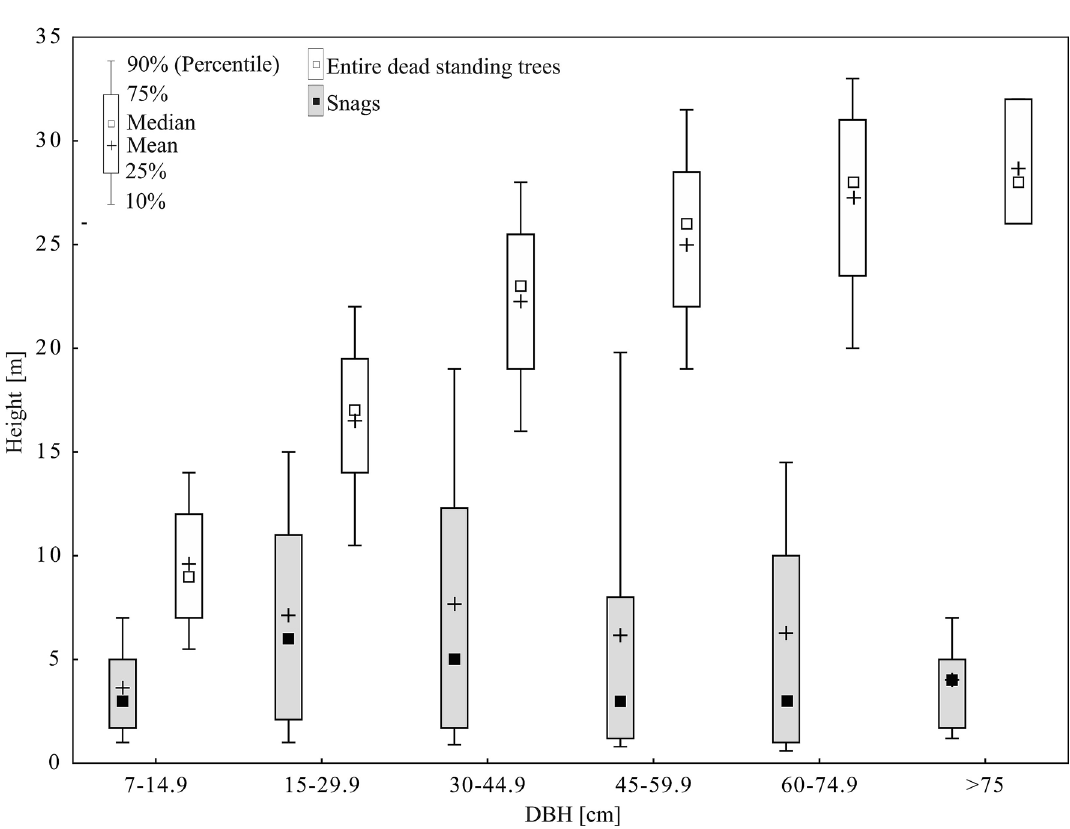
Figure 6. Relationship between the DBH and height of snags and entire dead standing trees (data for all 107